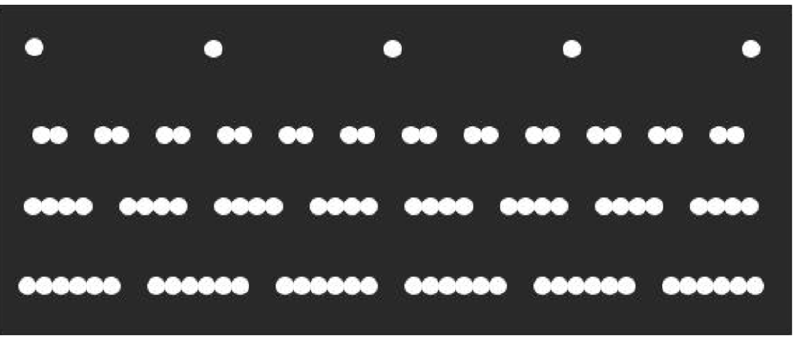
Figure 2. Stimuli used in Experiment 1. Panel shows a single dot trial; a two dot string trial; a four dot string trial; a six dot string trial; only one row of stimuli was presented in a trial.